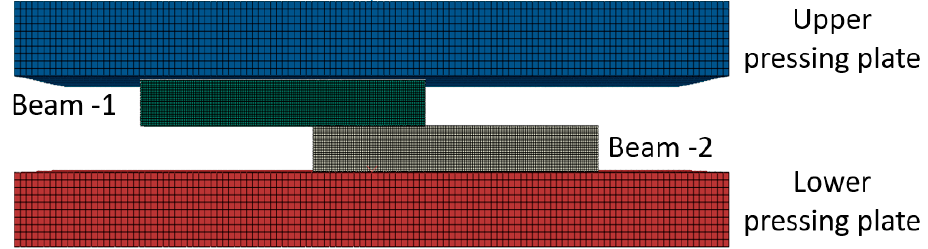
Figure 2. The geometry of the compression system represented in the model, with the 3D mesh used throughout this study (side view).